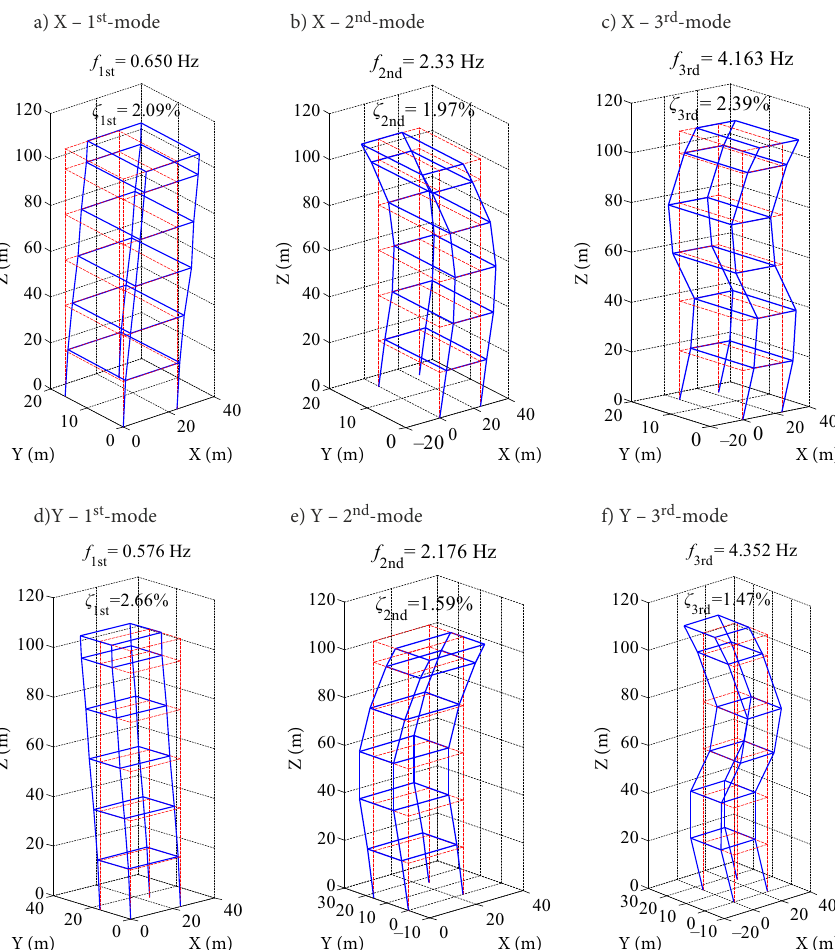
Figure 14. The first three modal parameters under ambient excitations identified by Morlet-type time-frequency wavelet